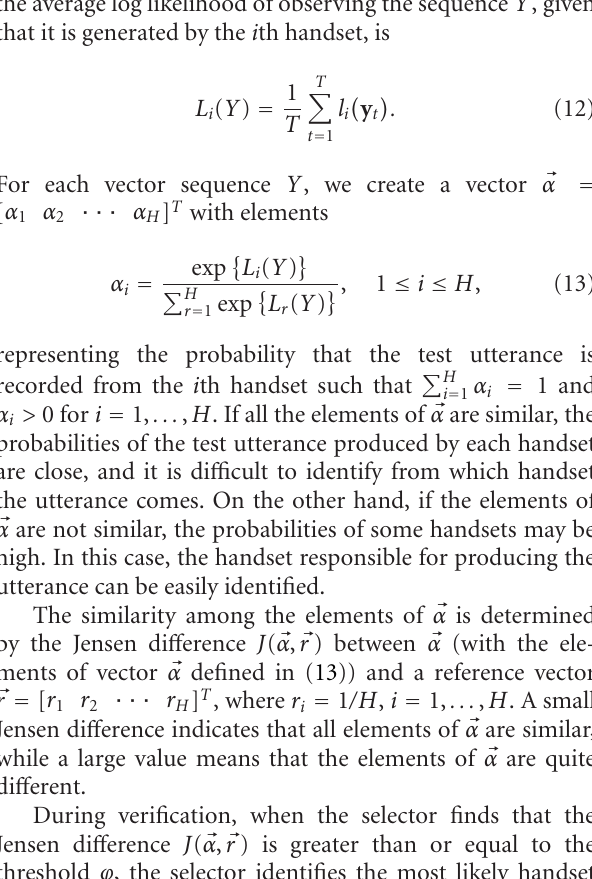
Figure 1: Speaker verification system with handset identification, OOH rejection, and handset-dependent feature transformation. for each utterance, the selector will either identify the